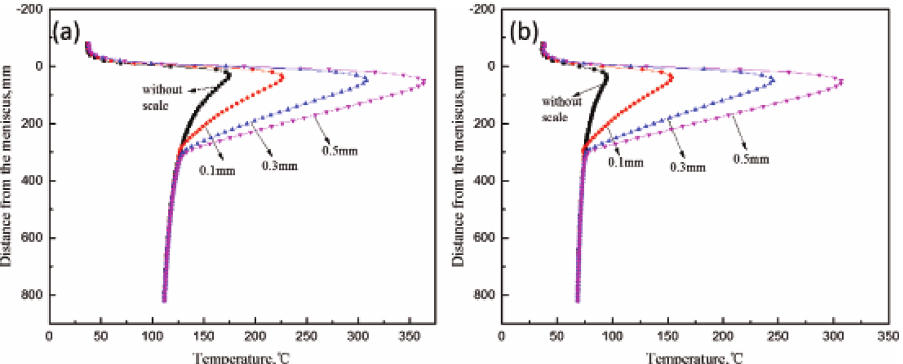
Figure 8: Longitudinal temperature variation of mold surface for different scale thicknesses on (a) hot face and (b) cold and 364 ο C (637 K), respectively, which exceeded the dized copper.